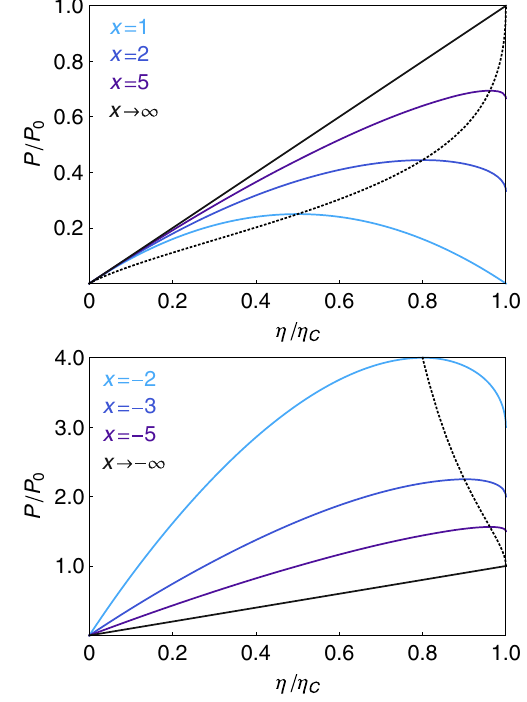
FIG. 2. Plots of the maximum power (57) in units of P 0 ≡ F 2 L T as a function of the normalized efficiency ¯ η ≡ η = η q qq c selected values of the asymmetry parameter x ≥ 1 in the upper and x < − 1 in the lower panel. For x → (cid:4) ∞ , convergence to P=P 0 ¼ ¯ η is observed. The dotted black lines correspond to the maxima of Eq. (57) for 0 ≤ x < ∞ in the first and − ∞ < x < − 1 in the second plot, thus indicating the relation between maximum power and efficiency at maximum power. The apparent diver- gence for negative x occurs in the limit x → − 1